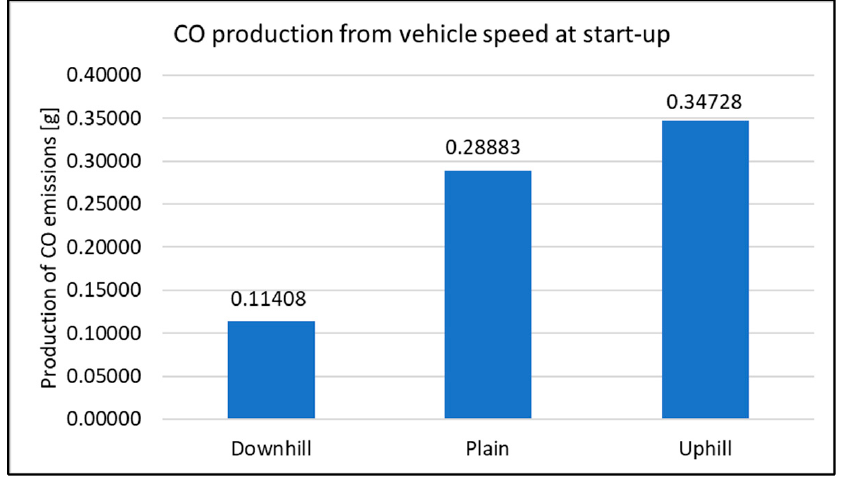
Figure 6. CO production at start-up.